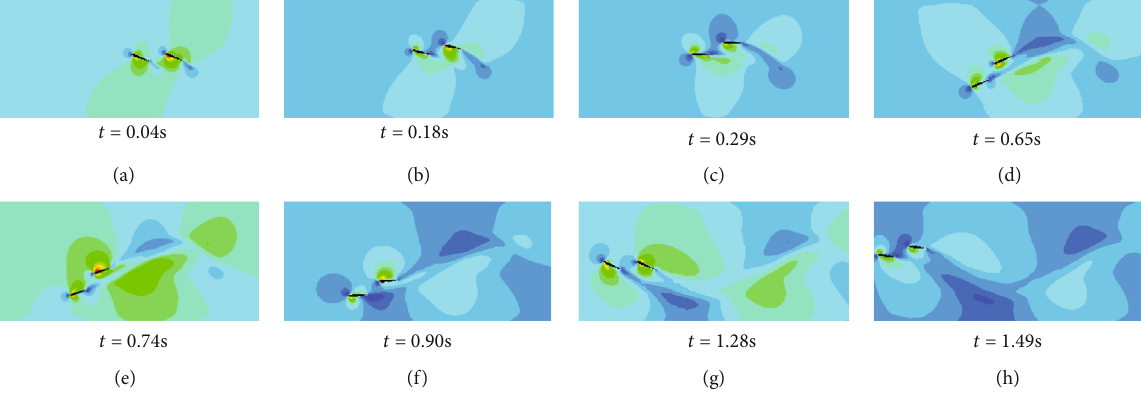
Figure 12: Wake vortex of double caudal fi n pressure cloud.